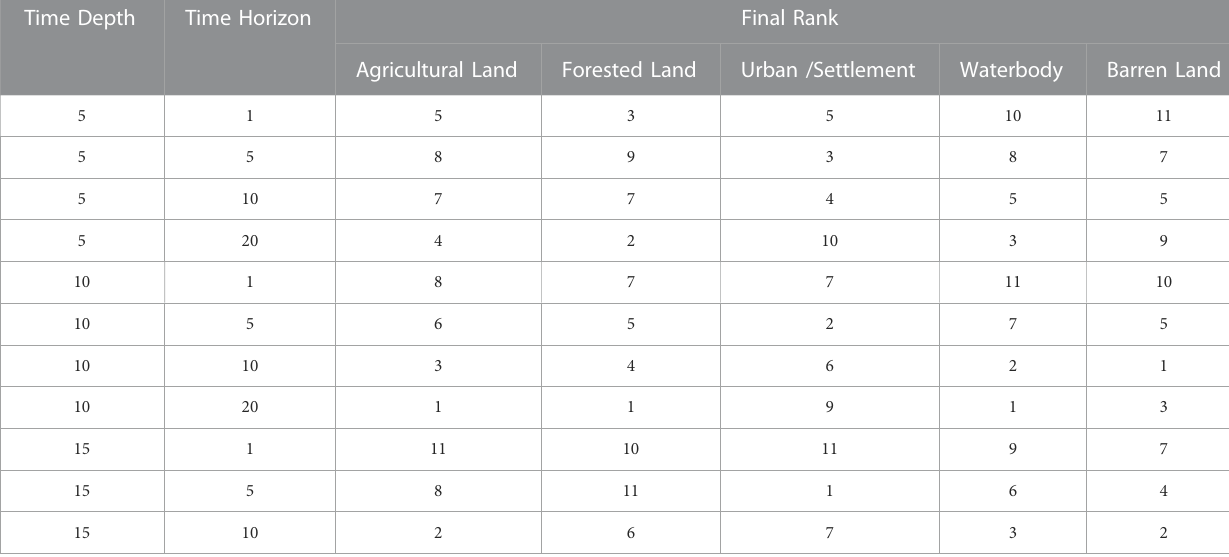
TABLE 6 Rank of different combinations of time depths and time horizons evaluation for land loss by LULC type. Time